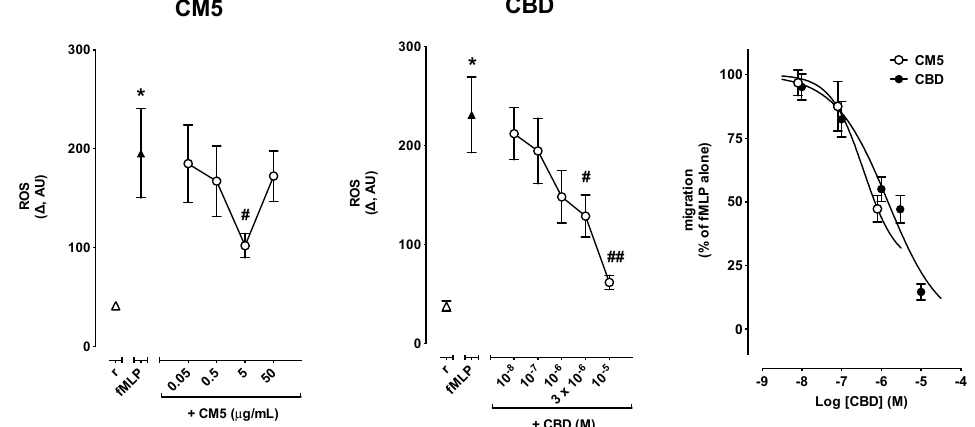
Figure 5. Effect of CM5 and CBD on fMLP-induced reactive oxygen species (ROS) production in PMN. ROS changes were calculated over 30 min as the difference ( Δ ) between resting levels and peak levels induced by fMLP. * p < 0.001 vs. resting, # p < 0.05 and ## p < 0.001 vs. fMLP alone.